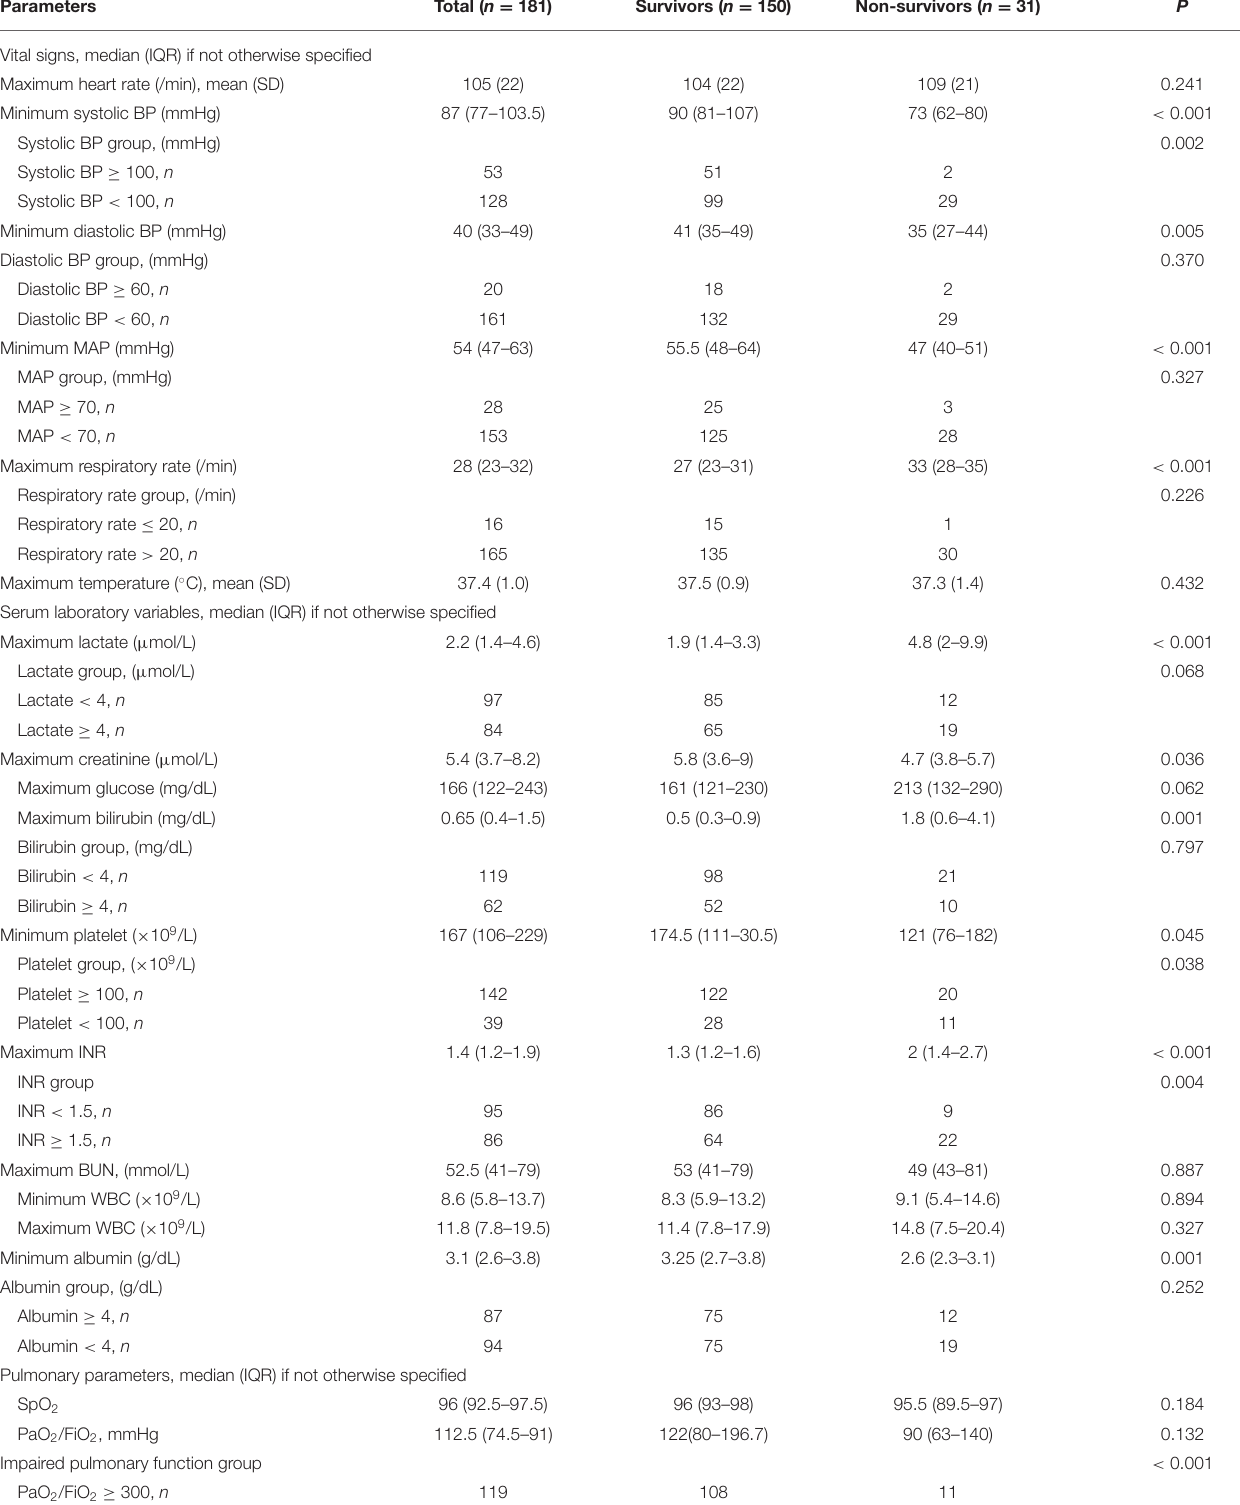
TABLE 2 | Laboratory indexes within 24h after ICU admission in patients with sepsis who received